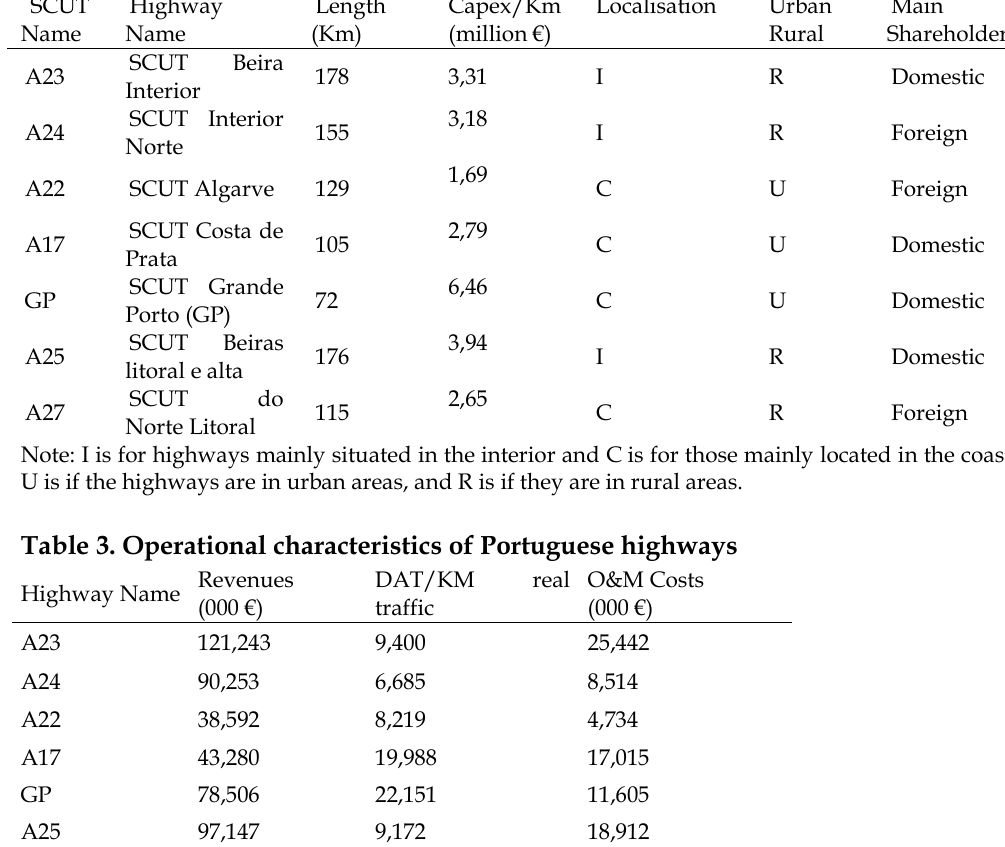
Table 2. General characteristics of Portuguese PPP highways SCUT